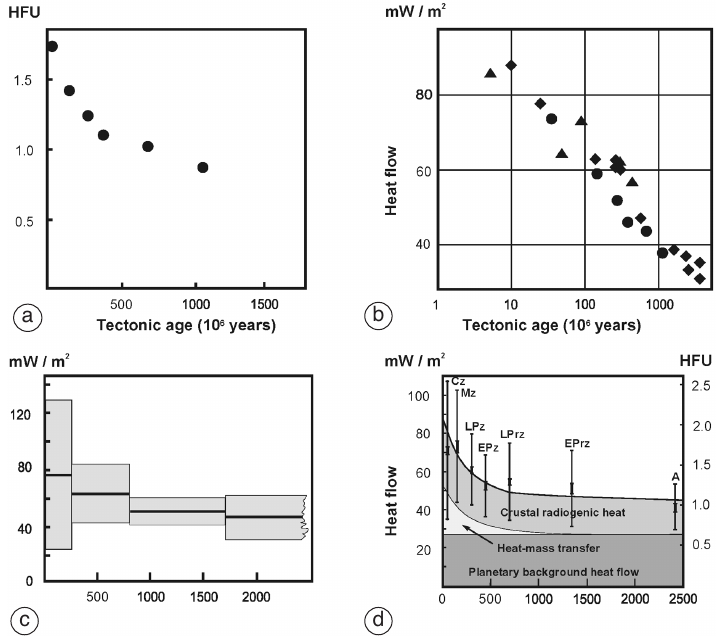
Fig. 1a-d. «Heat flow-age dependence». The plots of conductive heat flow density, q , versus age of tectono- magmatic activity: a) from Polyak and Smirnov (1968); b) dots from Polyak and Smirnov (1968), triangles from Cermak et al. (1976), diamonds from Kutas et al. (1976); c) reproduced from data in Sclater et al. (1980, 1981), the mean q -values in four age-specific provinces of continents and the relevant data scatters are shown as the lengths of straight line and shaded band, respectively; d) from Vitorello and Pollack (1980, fig.1), the data points, the standard errors of the mean and the standard deviations are shown for Cenozoic, Mesozoic, Late and Early Paleozoic, Late and Early Proterozoic an Archean provinces, the heat flow components correspond to radiogenic heat from the crust (I), effect of «transient thermal perturbation associated with tecto-genesis» (II) and